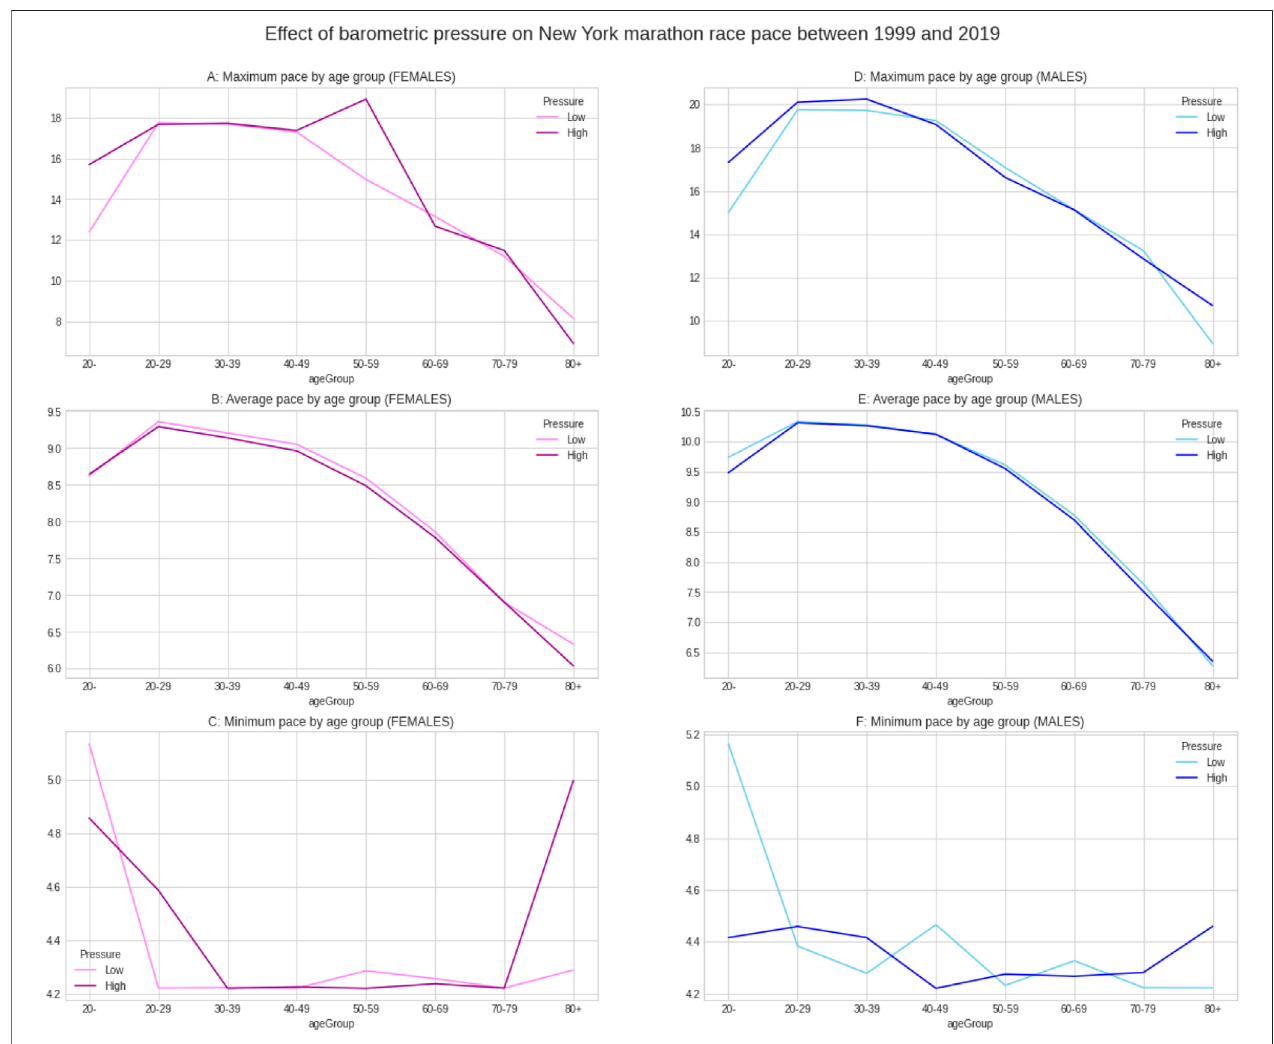
FIGURE 12 | Effect of barometric pressure on running speed by age